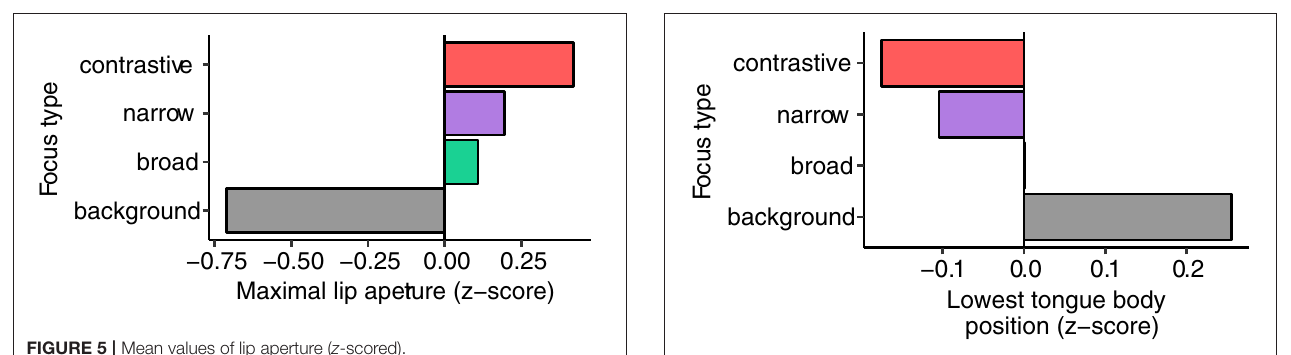
FIGURE 5 | Mean values of lip aperture ( z -scored).